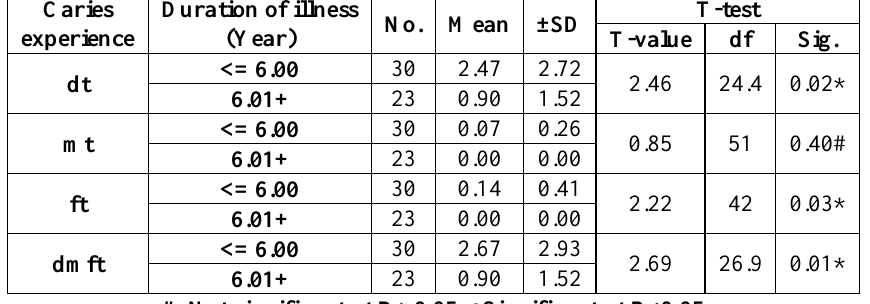
Table 6: Caries experience of permanent dentition (mean and standard deviation) among patient with Juvenile Idiopathic Arthritis according to duration of illness Caries Duration of Mean experience illness